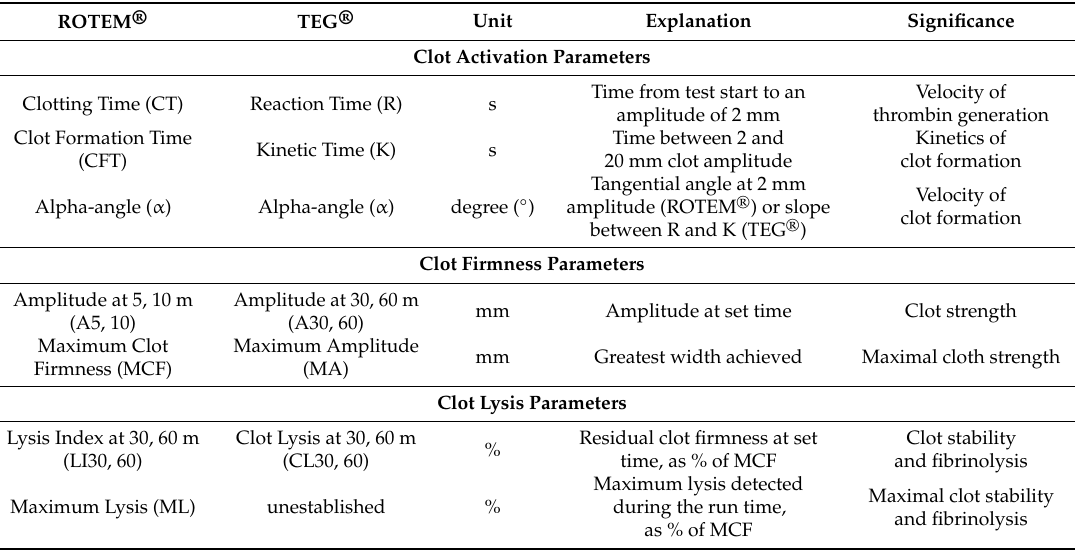
Table 3. Comparison of ROTEM ® and TEG ®